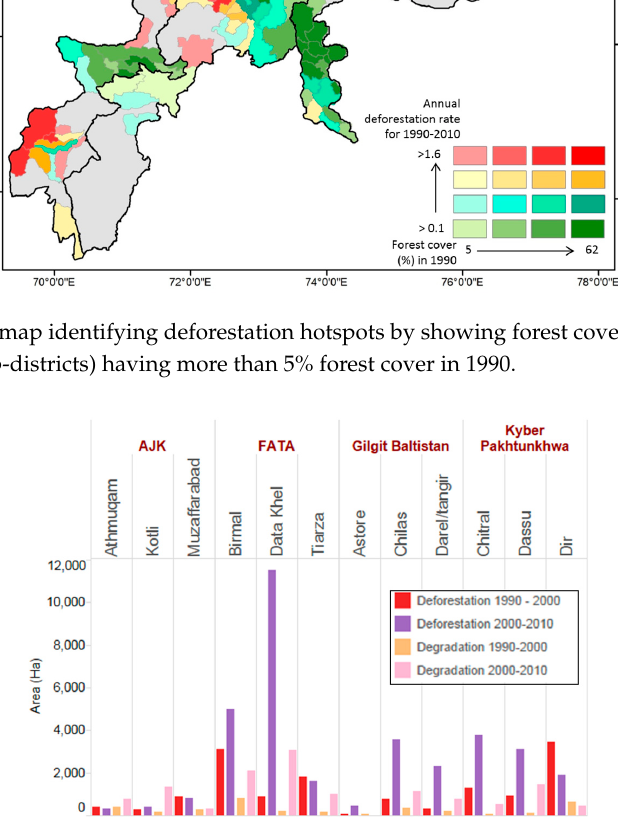
Figure 5. Forest cover and deforestation distribution as a function of elevation.